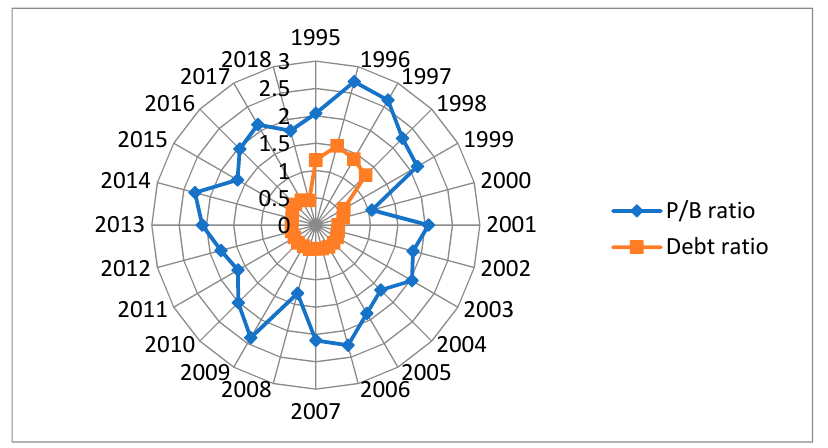
Figure 6. Volatility of average P/B ratio and average debt ratio over the years .